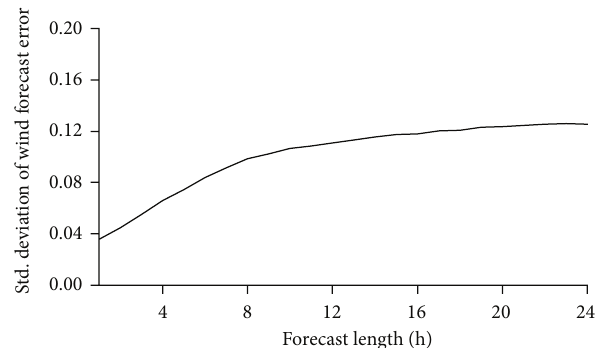
Figure3:Std.deviationofwindforecasterrorwithdifferentforecast